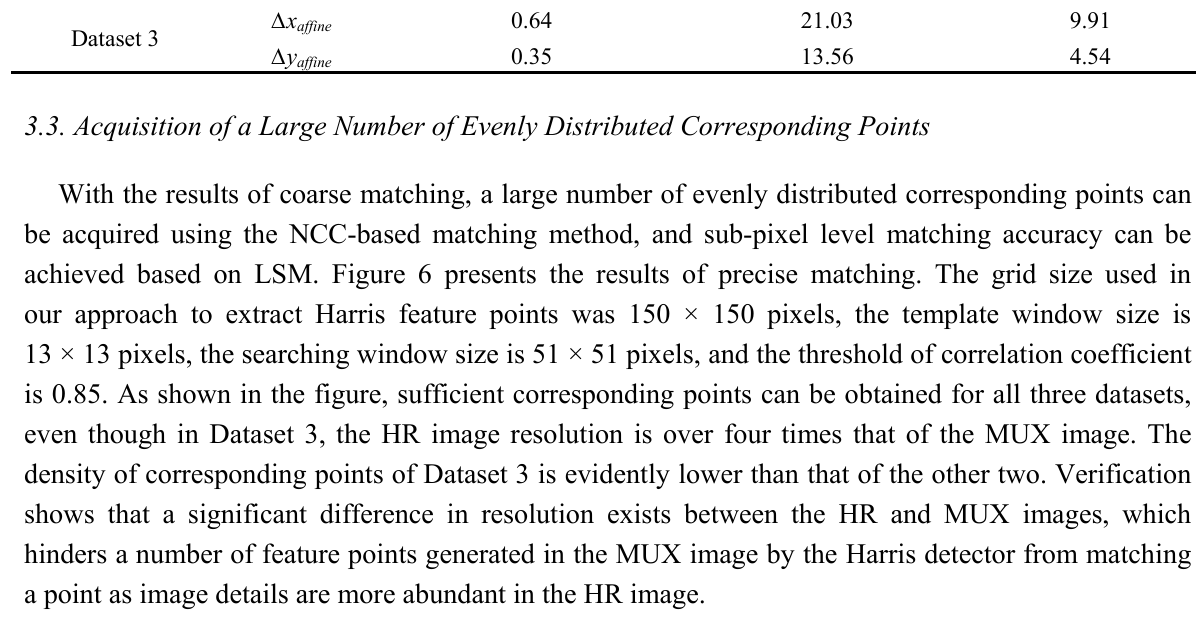
Figure 6. Results of precise matching. Only correct matches are indicated on the images. ( a ) Dataset 1. A total of 6,456 Harris feature points were extracted and 4,945 pairs of points were successfully matched, of which 52 pairs were excluded as false matches. ( b ) Dataset 2. A total of 5,977 Harris feature points were extracted and 3,467 pairs of points were successfully matched, of which 117 pairs were excluded as false matches. ( c ) Dataset 3. A total of 20,431 Harris feature points were extracted and 7,224 pairs of points were successfully matched, of which 1,348 pairs were excluded as false